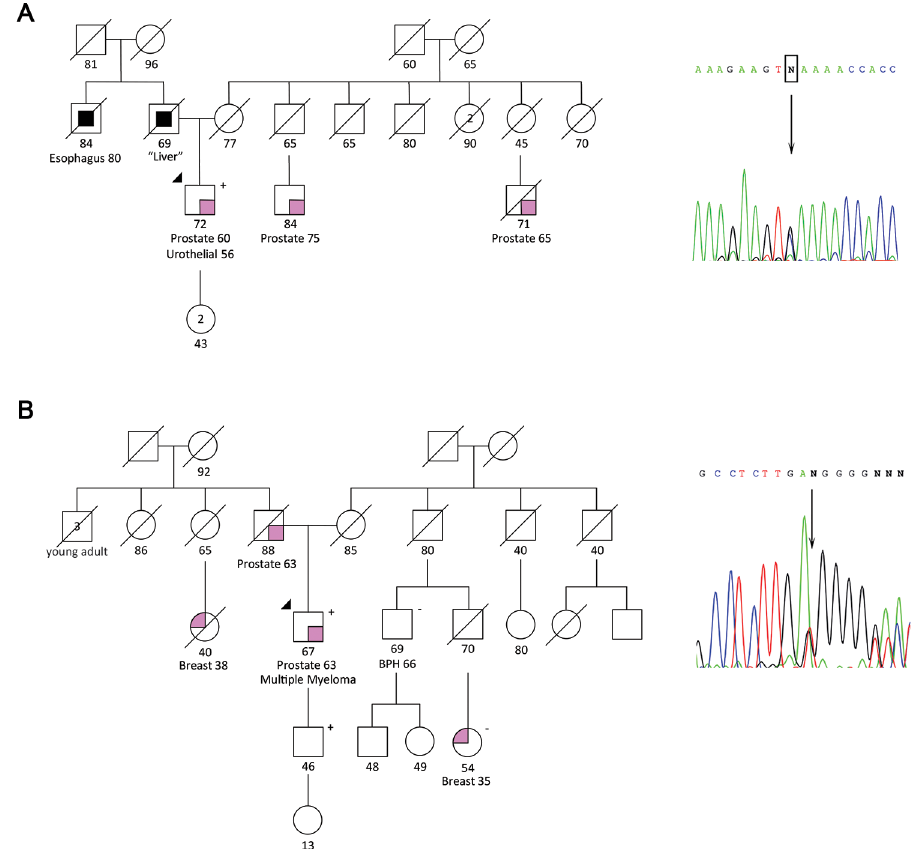
Fig 3. Pedigrees of patients harboring truncating/deleterious mutations in new candidate PrCa risk genes involved in other recessive disorders. (A) Patient HPC421 harboring the CEP57 nonsense mutation c.791C > G. (B) Patient HPC455 harboring the RECQL4 frameshift mutation c.2636del. Electropherograms of the Sanger sequencing validations are